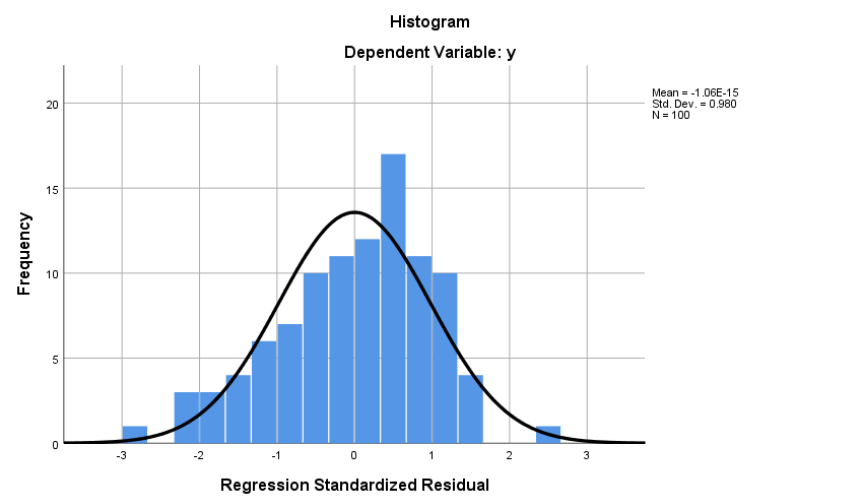
Detect Normality Using